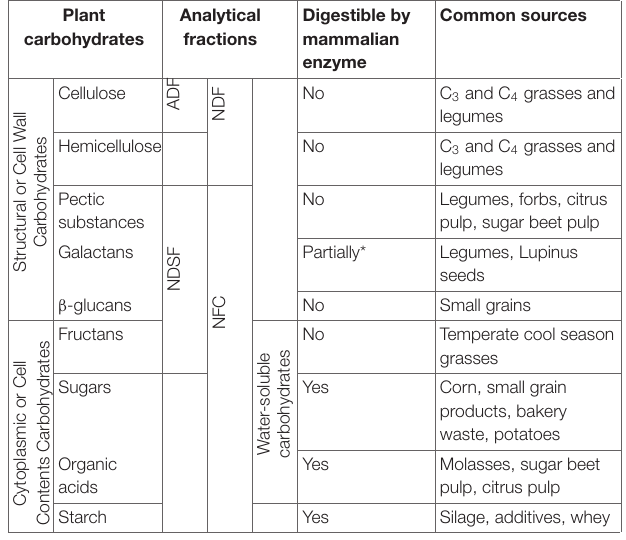
TABLE 1 | Structural (cell wall) and non-structural (cell contents) carbohydrate components of